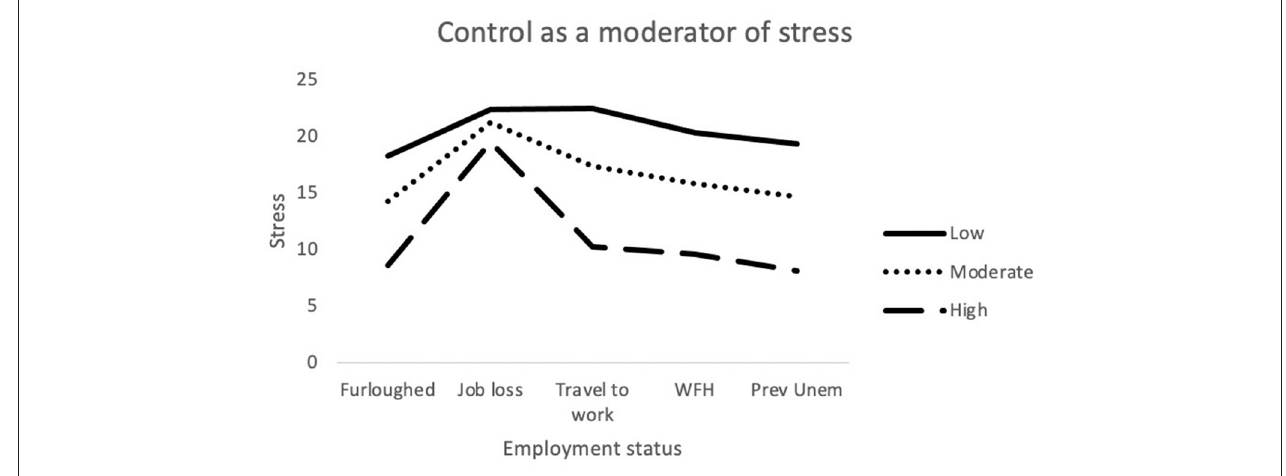
FIGURE 5 | Interaction between job outcome and Control for Stress. WFH, Employed (working from home); Prev Unemp, previously unemployed. job loss significantly interacted with both Challenge and